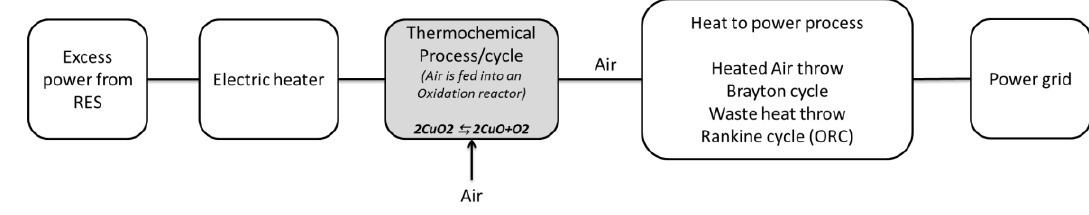
Figure 10. PtH / TCTES system developed by Wu et al. [316]. Figure 10. PtH/TCTES system developed by Wu et al. [322].